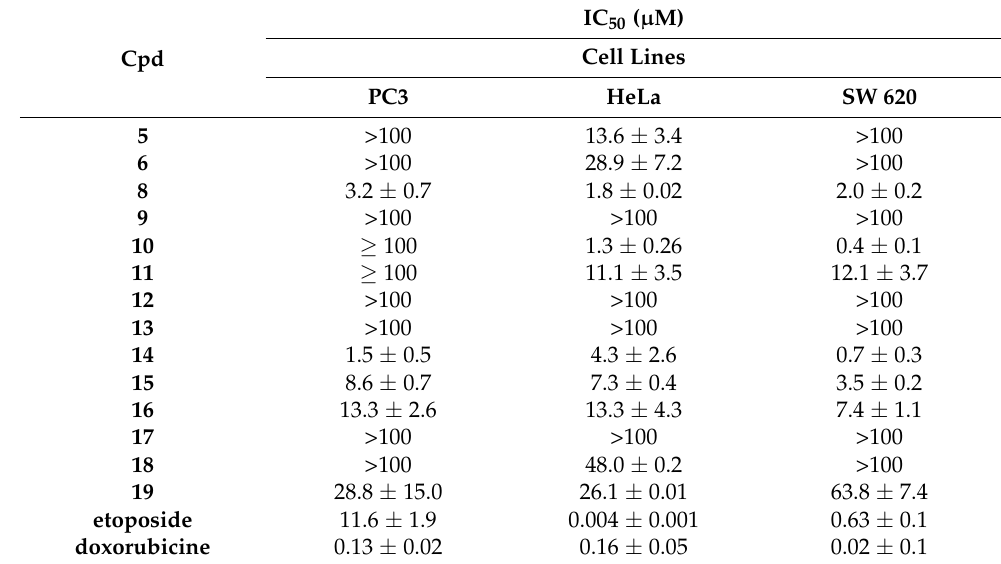
Table 2. In vitro antiproliferative activity against selected cancer cell